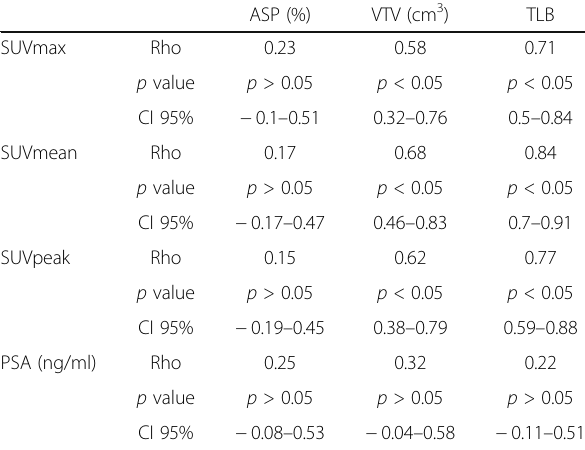
Table 4 Summary of correlations between asphericity, viable tumor volume derived from 68Ga-PSMA-PET, TLB, SUVmax, SUVmean, SUVpeak and the PSA value